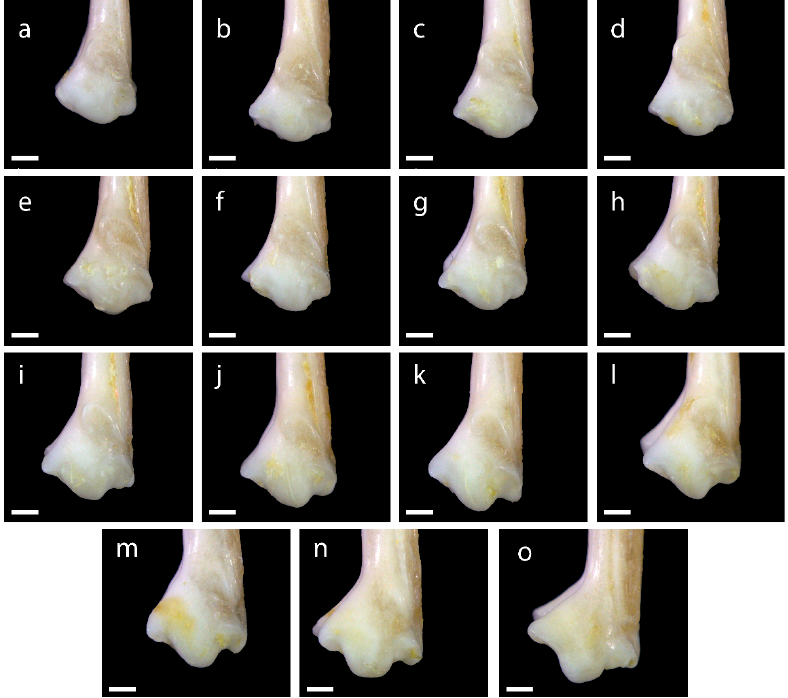
Figure A17. Microscopic images of the lateral right view of the pinnules of P. bichir PO2. The images ( a – o ) correspond to the 1st, 2nd, 3rd, 4th, 5th, 6th, 7th, 8th, 9th, 10th, 11th, 12th, 13th, 14th, and 15th pinnules, respectively. Scale = 1 mm.